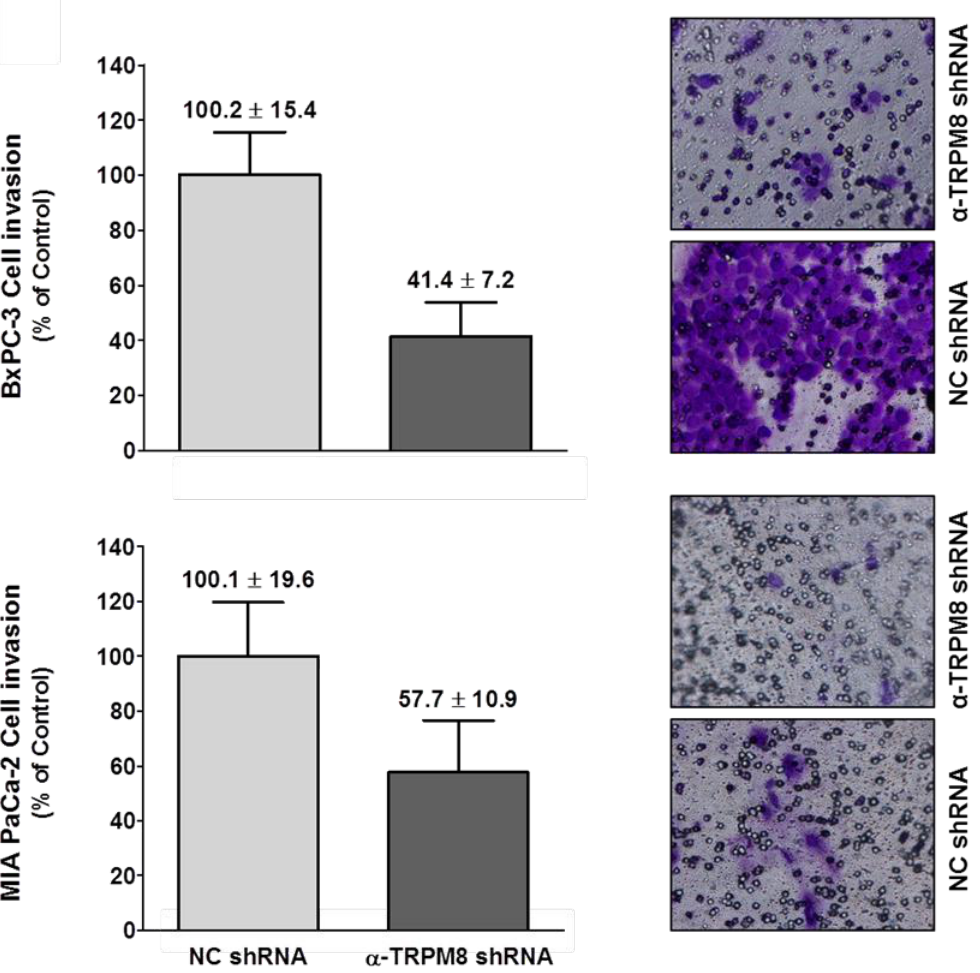
Figure 6. Short hairpin RNA-mediated silencing of TRPM8 impaired invasion of pancreatic adenocarcinoma cells. BxPC-3 and MIA PaCa-2 cells transfected with either anti- TRPM8 shRNA or NC shRNA were analyzed for cell invasion using the trans-well assay. Cell invasion is expressed % (mean ± standard error) of that in the cells transfected with control shRNA. Representative images of the invaded cells stained with crystal violet are shown at 200×